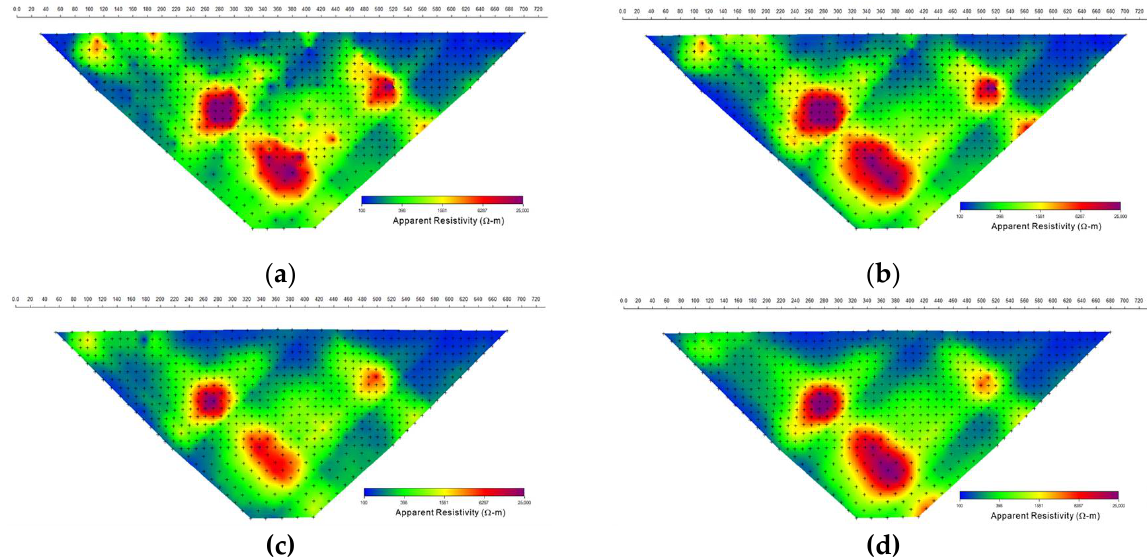
Figure 6. Pseudo-sections of survey line 1 of ( a , c ) observed and ( b , d ) predicted data obtained from ( a , b ) two- and ( c , d ) three-dimensional inversion.